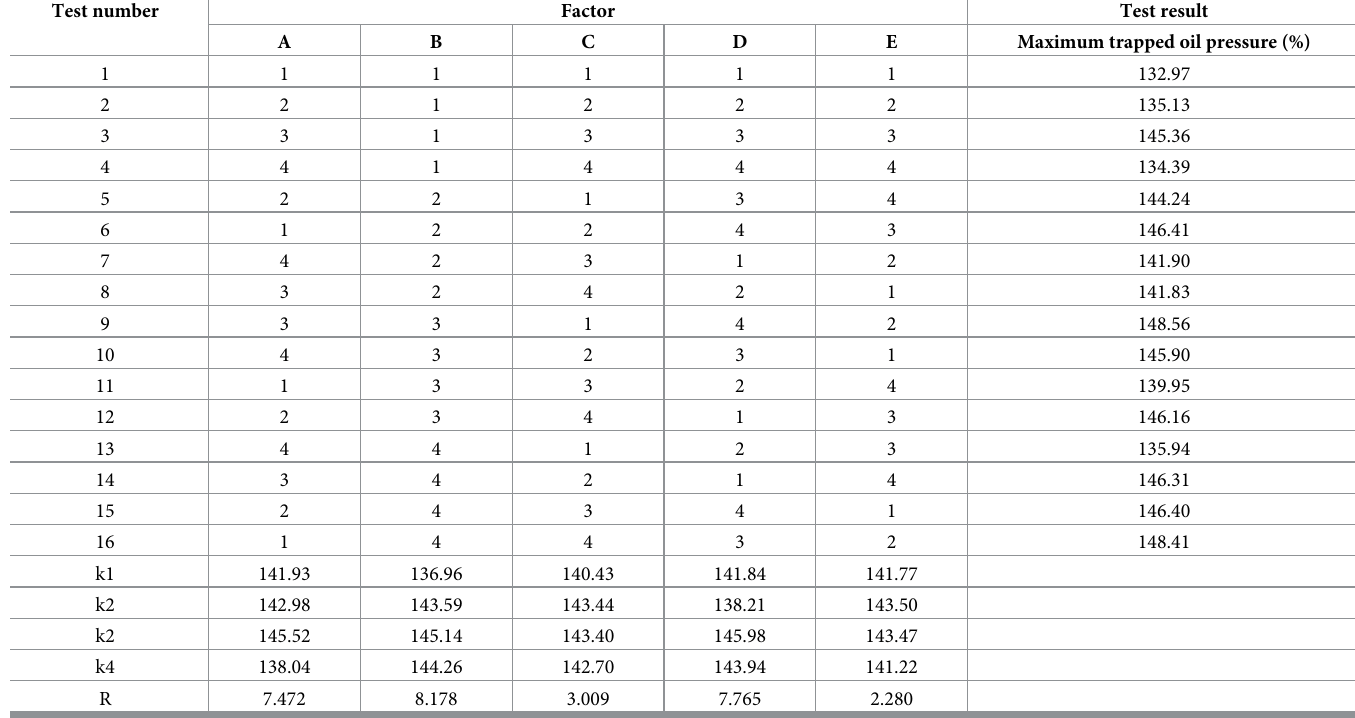
Table 10. Orthogonal test analysis table of the maximum trapped oil